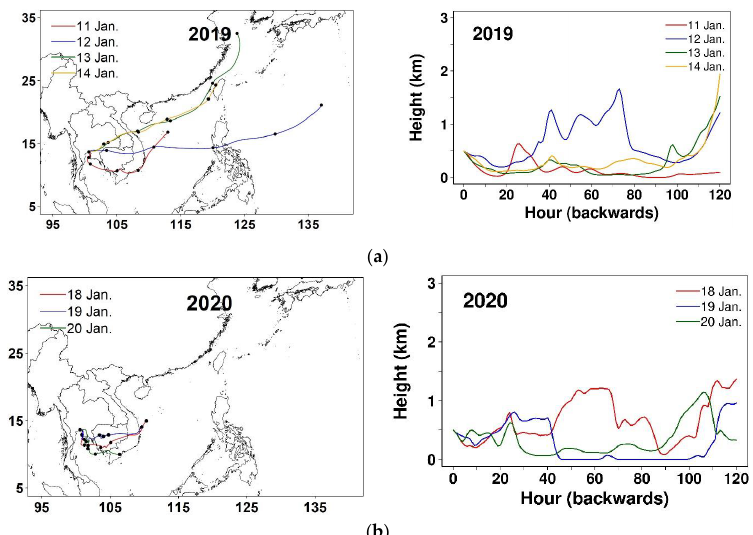
Figure 7. Horizontal ( left ) and vertical migration ( right ) of daily 120 h back-trajectories during ( a ) Episode 20; ( b ) Episode 25. Table 5. Effect of biomass burning on different haze episodes.